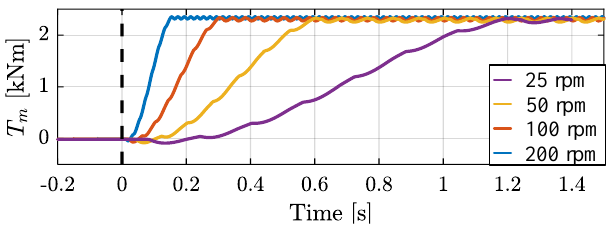
Figure 18. Transient response FSDS in the time domain operating at various